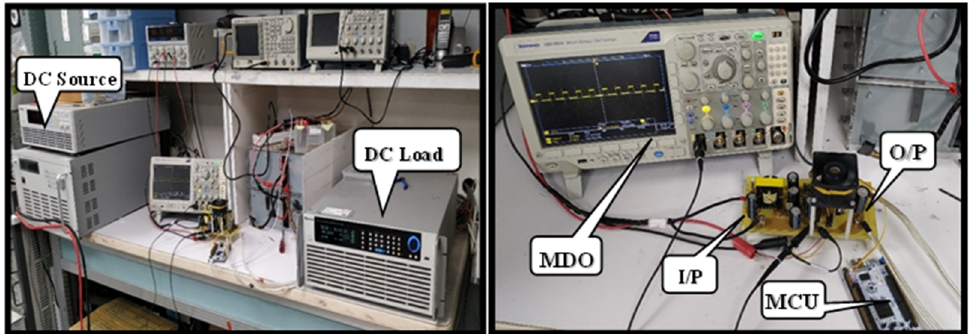
Figure 18. Hardware prototype developed in our lab.